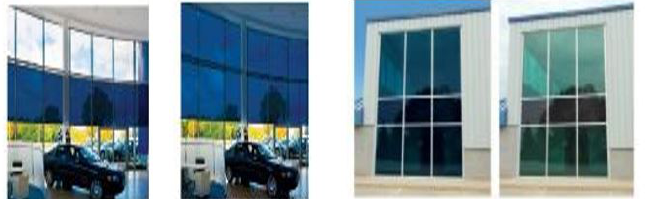
Figure 11. the Cars display store in Singapore ascontrolling the size of the smart application , the color of the light radiation and the light intensityin the windows. (Mahdavinejad,Bemanian & Khaksar, 2011) b. (Electro-chromic materials and Suspended particles applications): Electro-chromic materials change color while applying electrical voltage. Electro-chromic windows darken when a voltage is applied and become transparent when the voltage is removed. (Leydecker, 2008) as shown in Fig (13). The electricity rearranges the suspended particles to permit the needed light, as the range of light emission begins from 1% till 57%. (”How Smart Windows Work”,